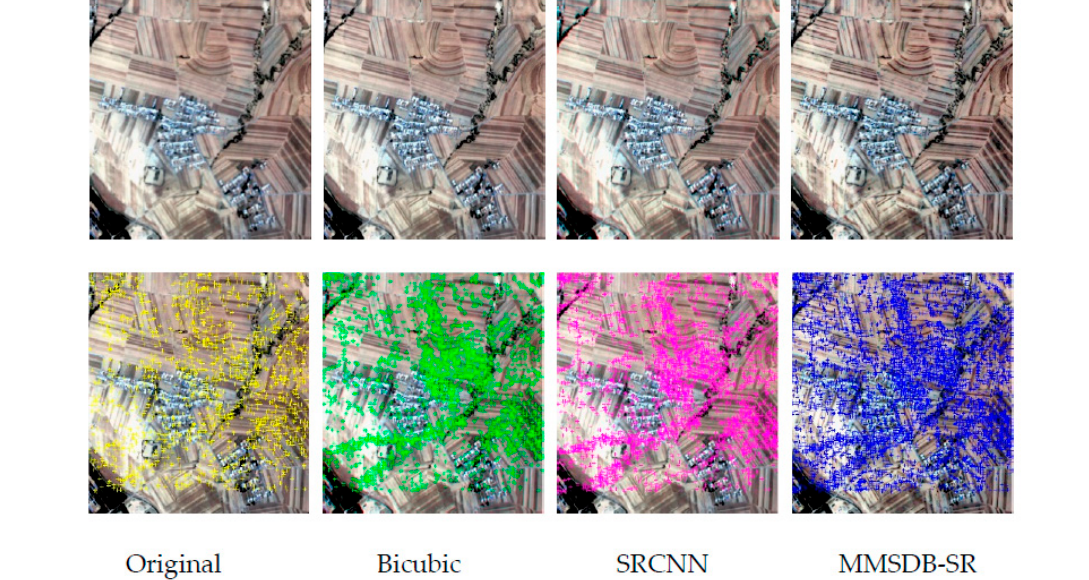
Figure 9. Feature-point-extraction results.